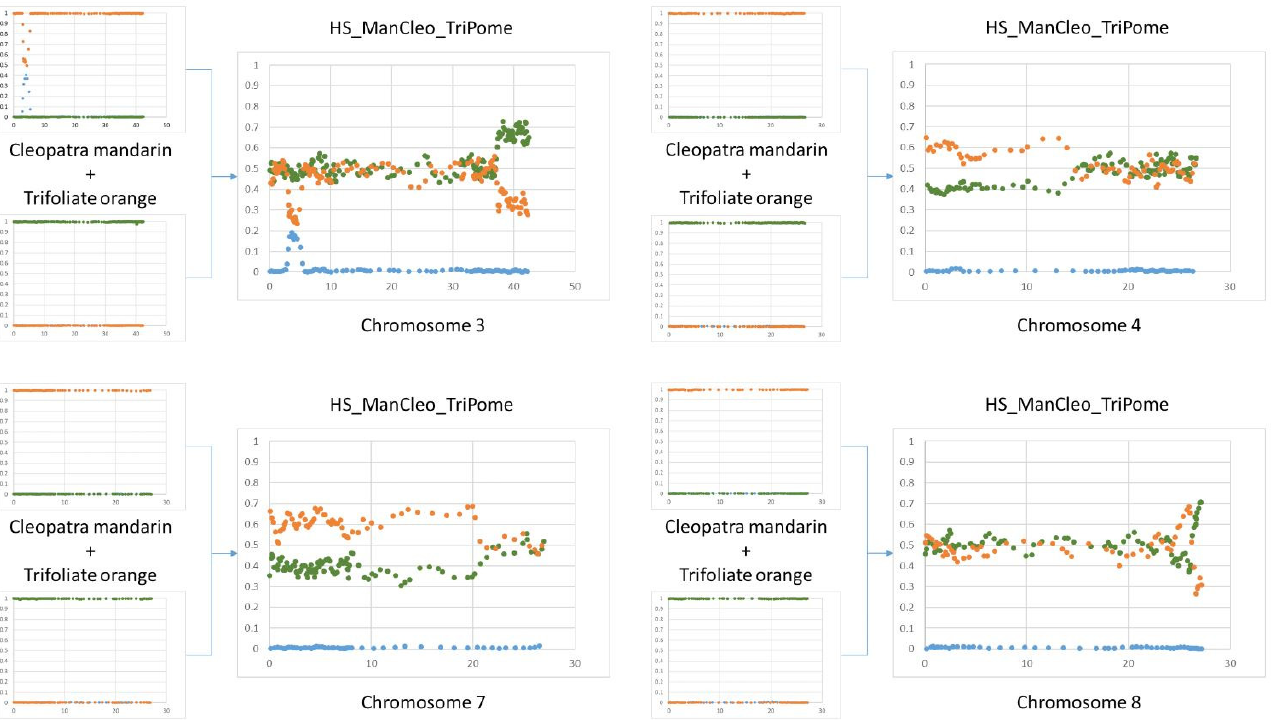
Figure 7. Frequencies of the diagnostic alleles of the three ancestral genomes along four chromosomes of the somatic hybrids between Cleopatra mandarin and P. trifoliata cv Pomeroy. Green: P. trifoliata ; orange: C. reticulata ; blue: C. maxima . The unit of the x axes is Mb.